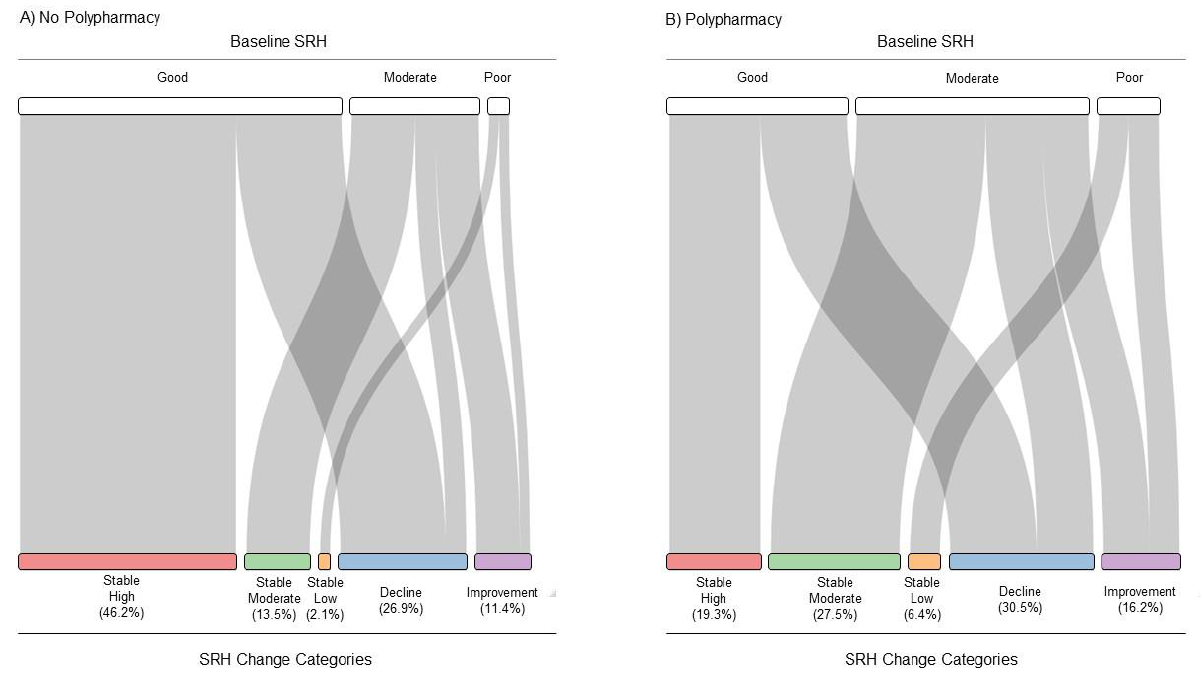
Figure 2. Distribution of self-rated health (SRH) at baseline (top part) of participants ( A ) without polypharmacy and ( B ) with polypharmacy and their assignment to SRH-change categories (bottom part) over the period of four years. The colors correspond to SRH-change categories in Figure 1.